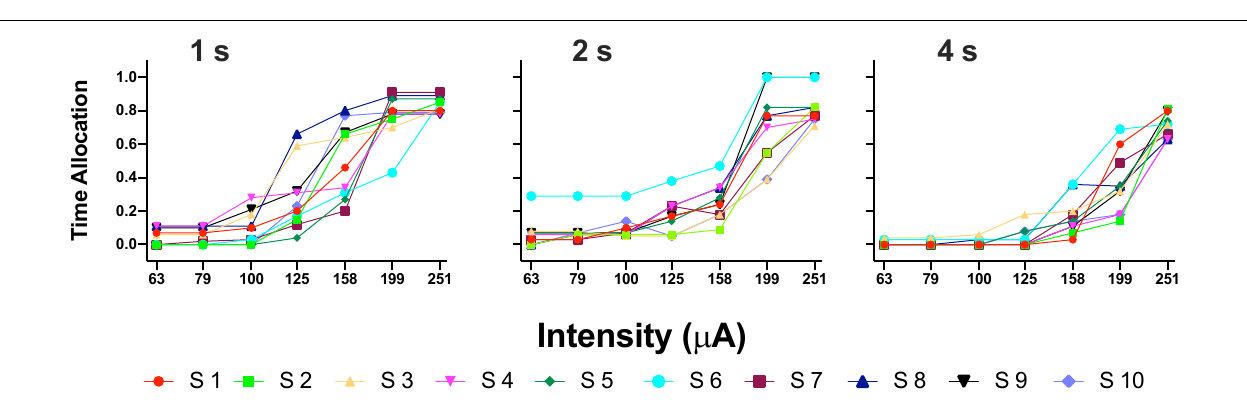
FIGURE 4 | Time allocation as a proportion of trial duration in each trial series. Plots in Figure 3 were obtained from the averaged parameters of individual plots. TABLE 1 | Mean goodness of fit of all series that correspond to each plot of TA. Time allocation: goodness of fit (R